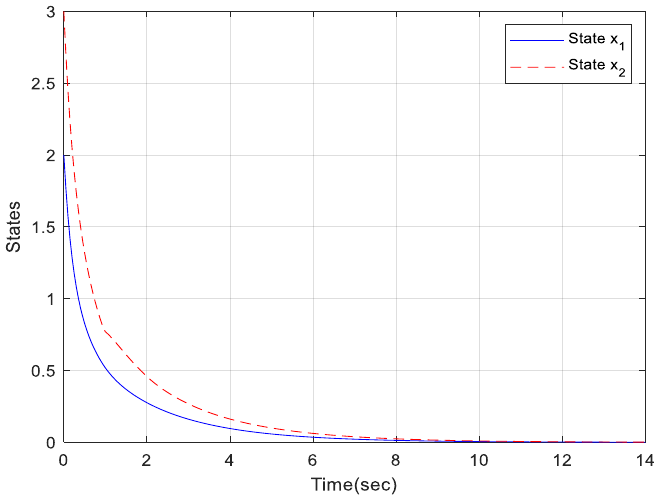
Figure 3. Trajectories for 𝑥 1 and 𝑥 2 .